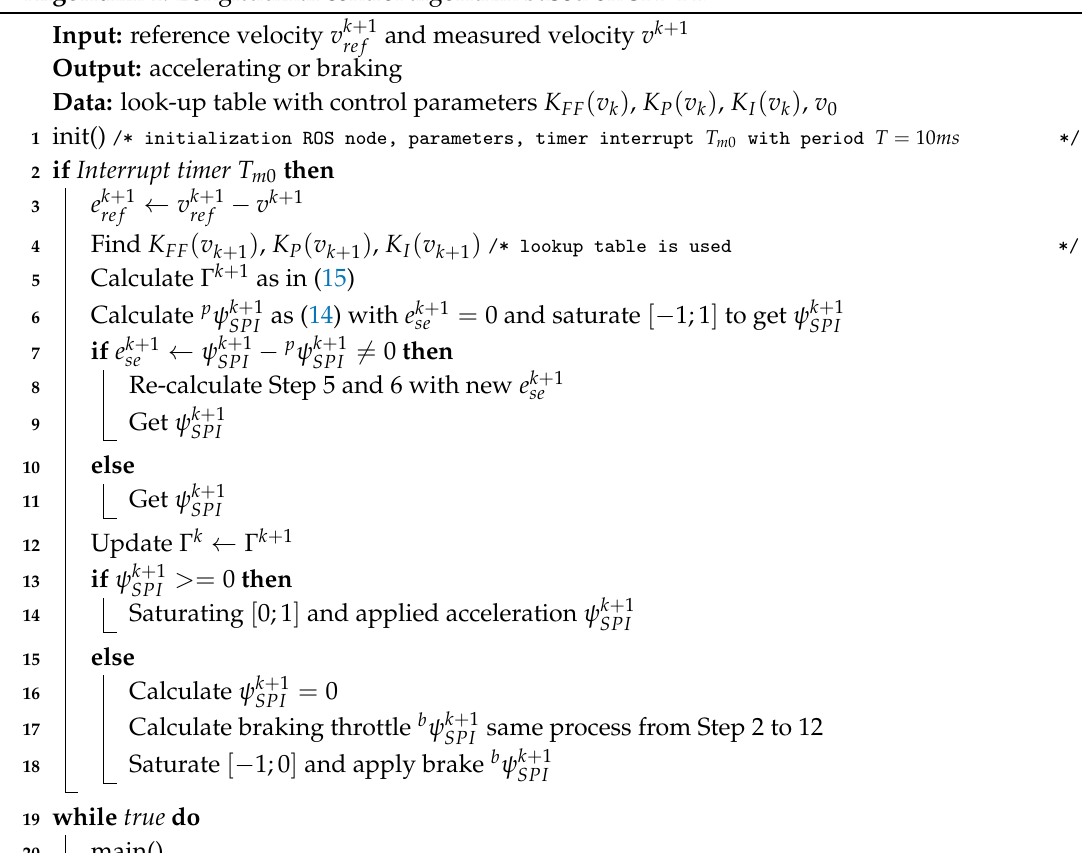
Algorithm 1: Longitudinal control algorithm based on